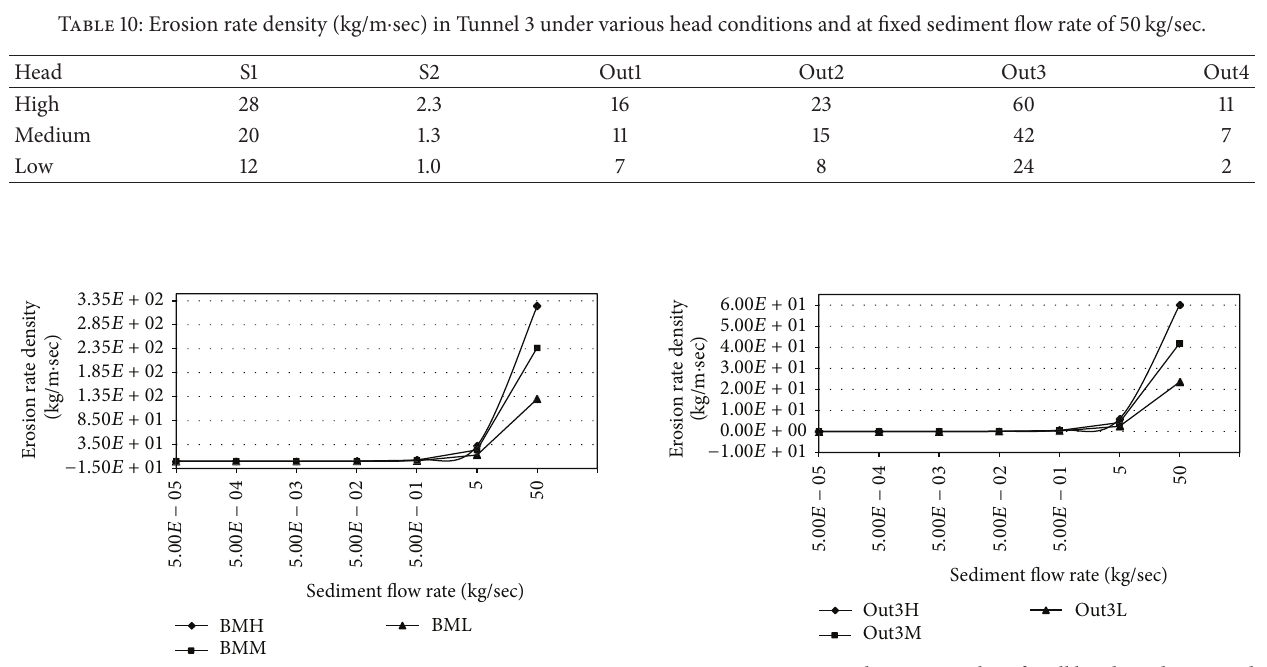
Figure 4: Erosion rate density at outlet 3 for all head conditions and different sediment flow rate in Tunnel 3 (Out: outlet; H: high head; M: medium head; L: low